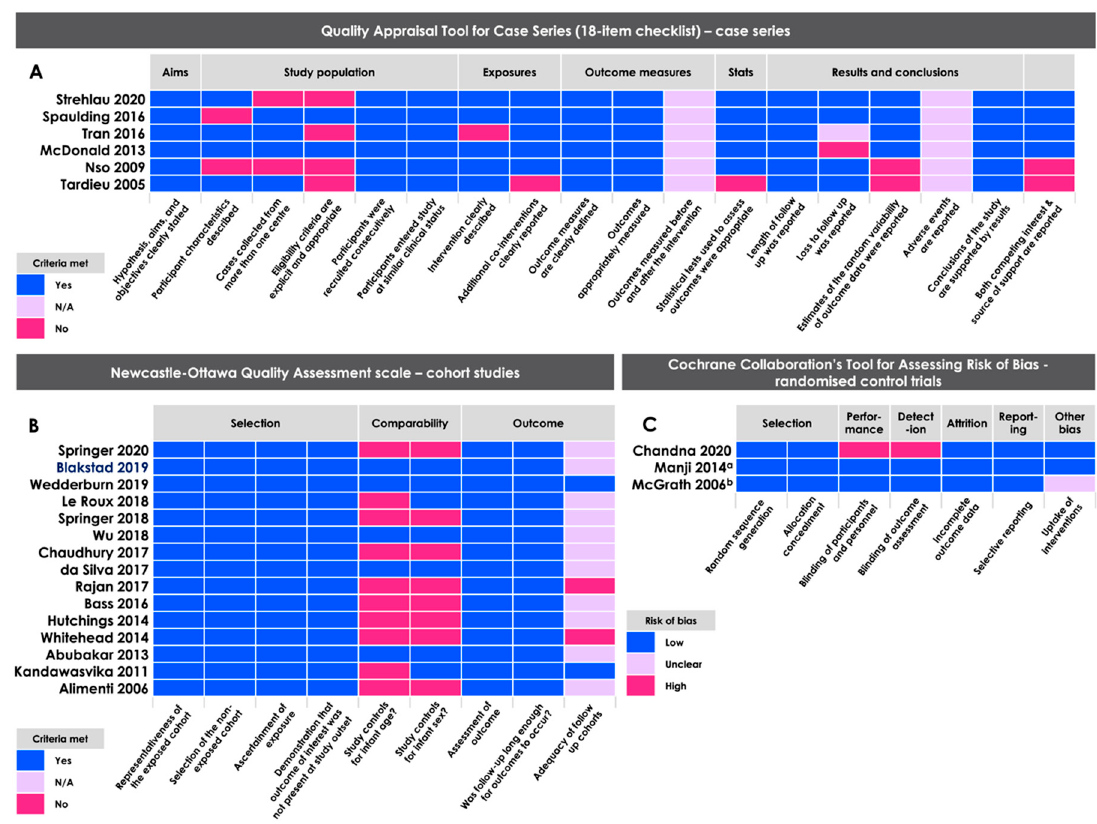
Figure 3. Quality assessment of articles according to study design using the ( A ) Quality Appraisal Tool for Case Series (18-item checklist, case series [23]), the ( B ) Newcastle–Ottawa Quality Assessment Scale (cohort studies [22]), and the ( C ) Cochrane Collaboration’s Tool for Assessing Risk of Bias (randomized controlled trials [24]). a This sub-study was a secondary endpoint of a larger randomised controlled trial. This sample includes children who attended only one of the three research clinics and 12% of the infants who attended follow up at 15 months overall (71.9% of the total number of infants who were randomized). Demographic characteristics across the placebo and multivitamin sub-study groups remained similar, so risk of selection bias (internal) was assessed as low. b While authors report treatment compliance for the randomized arms, it is not clear that authors considered treatment compliance for the population of mothers whose infants had at least one neurodevelopmental assessment and were included in this analysis (327 of 1078 assigned to treatment arms).